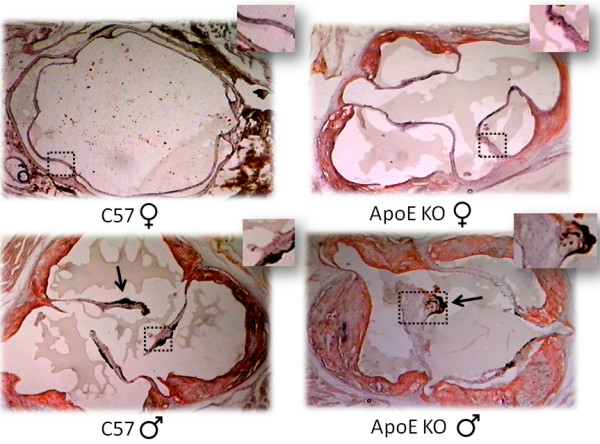
Typical photomicrographs of the aortic valves of male and female mice from the normocholesterolemic C57 and hypercholesterolemic ApoE KO groups. Squares indicate the maximum thickness of each valve. Arrows indicate valvar lesions in males of both C57 and ApoE KO groups as indicated by hemosiderin deposition. The sections were stained with both Oil-Red-O and hematoxylin. Magnification: 400×.